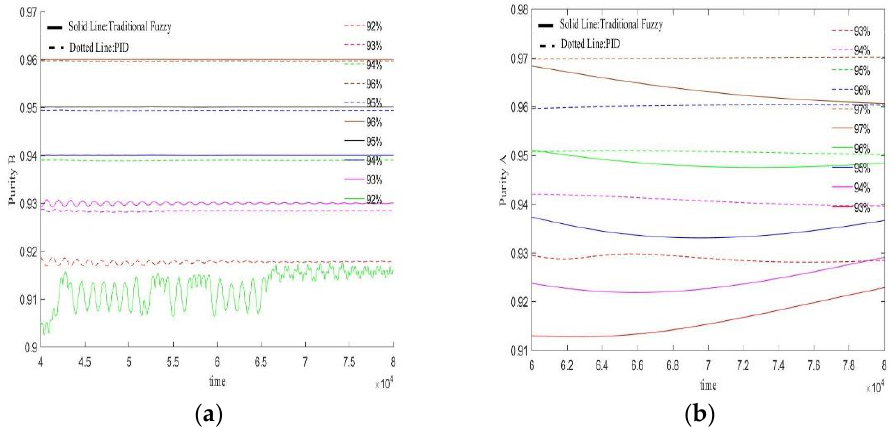
Figure 18. Under the change of the feed port concentration C f = 4.5 → 5.2. ( a ) Extraction outlet